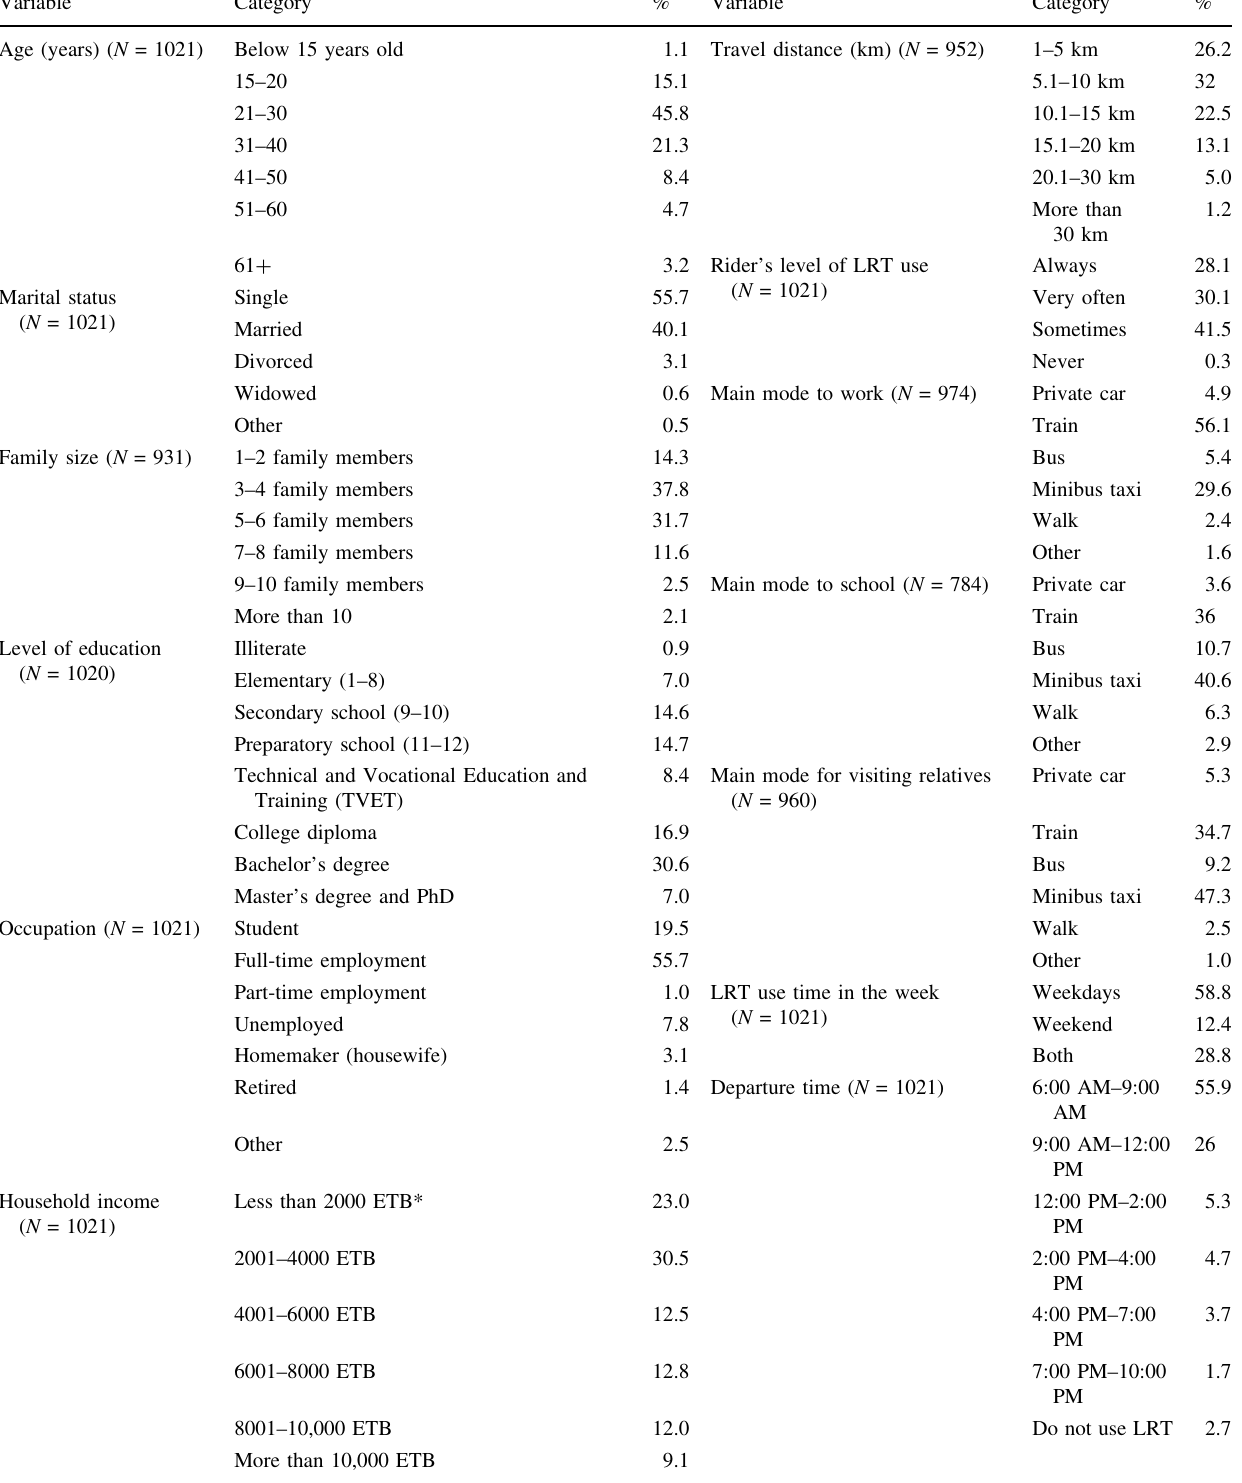
Table 1 Socioeconomic and travel characteristics of survey